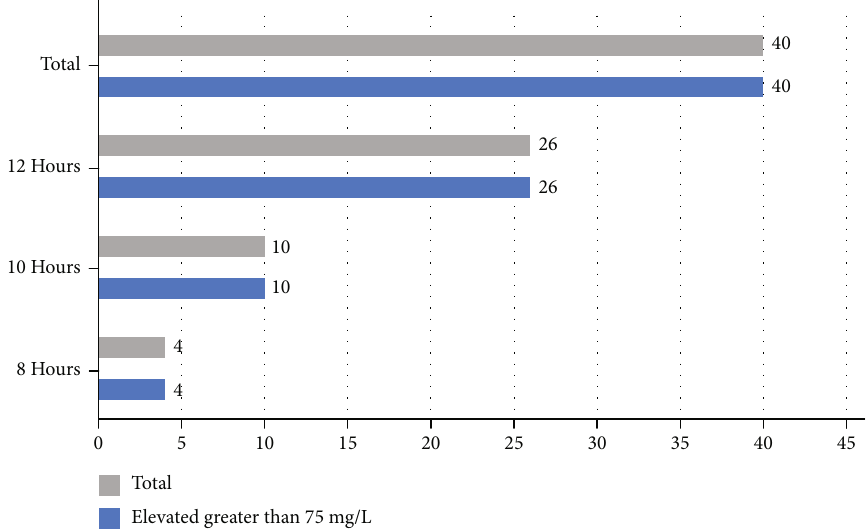
Figure 7: Result of the quanti fi cation of total phenols in relation to the working day.